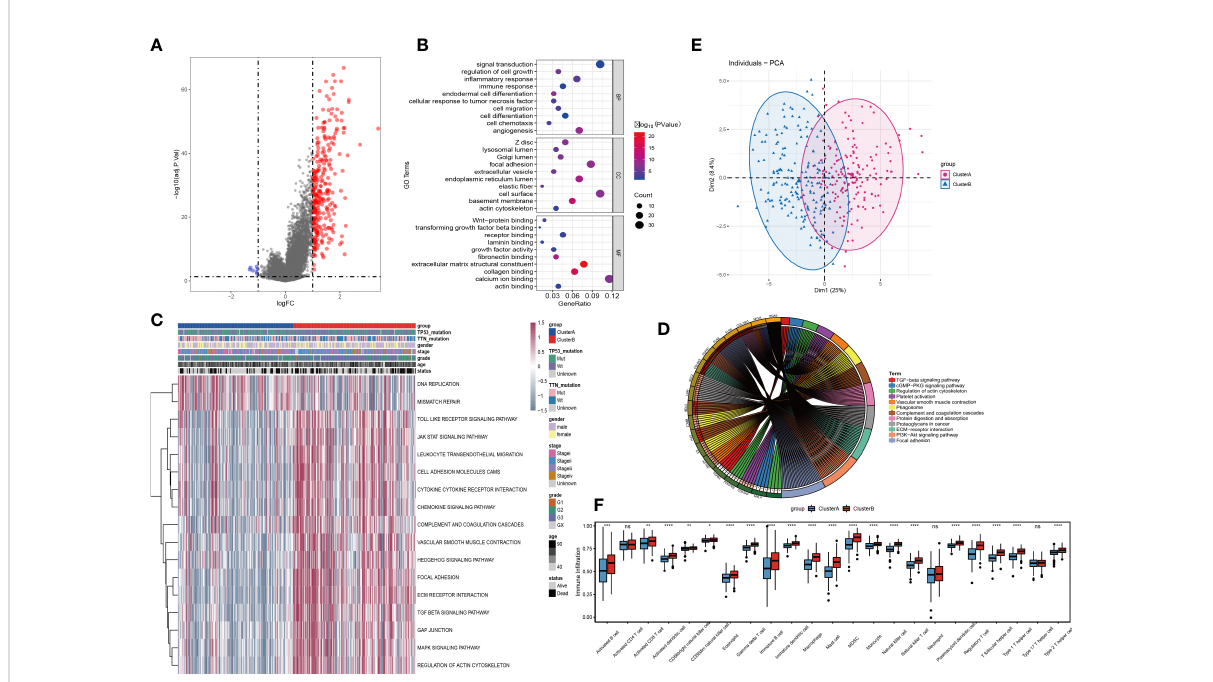
FIGURE 5 Identi fi cation and functional analysis of differentially expressed genes among tumor angiogenesis subtypes. (A) Volcano plot for differential expression; (B) Bubble plot for GO enrichment analysis of differentially expressed genes; (C) Differential expression pathways for GSVA analysis; (D) PCA analysis for expression pro fi les; (E) KEGG enrichment analysis for differentially expressed genes Circle; (F) Analysis of tumor immune cell in fi ltration. Differences between the two groups were analyzed using the independent t-test, values are expressed as the means±sem. ns, P>0.05; *P < 0.05; **P < 0.01; ***P < 0.001; ****P <